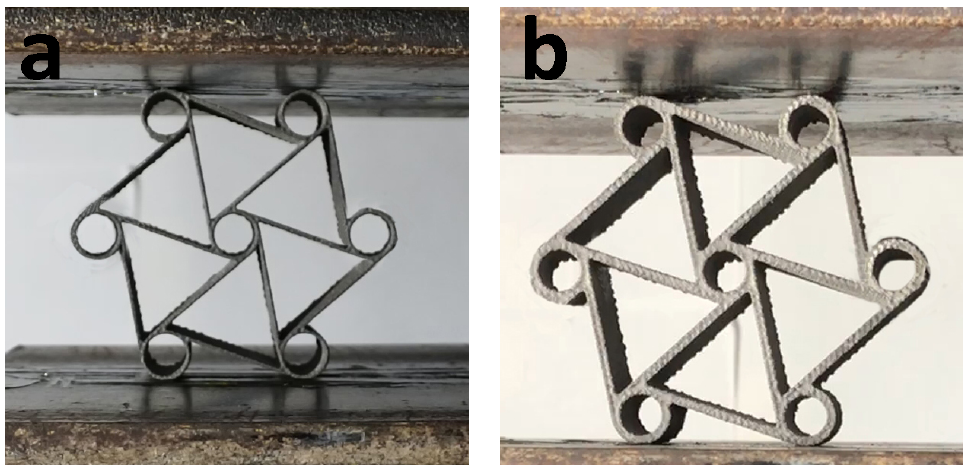
Figure 5. Crush test setup and specimens of chiral units with ( a ) 0.8 mm and ( b ) 1.6 mm liga- ment thickness.